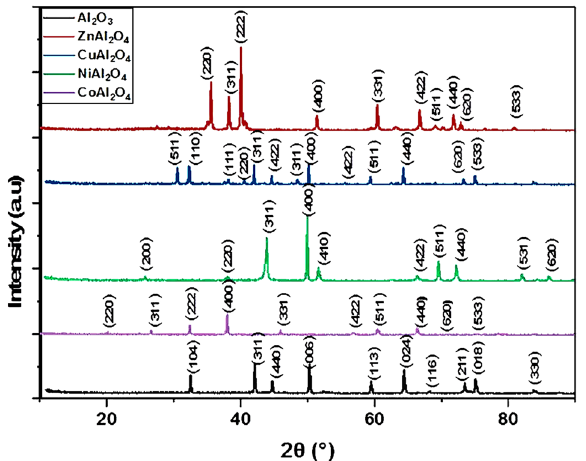
Figure 1. XRD spectra of Al2O3 NPs, ZnAl2O4, CoAl2O4, NiAl2O4, and CuAl2O4 nanocomposites at 1100